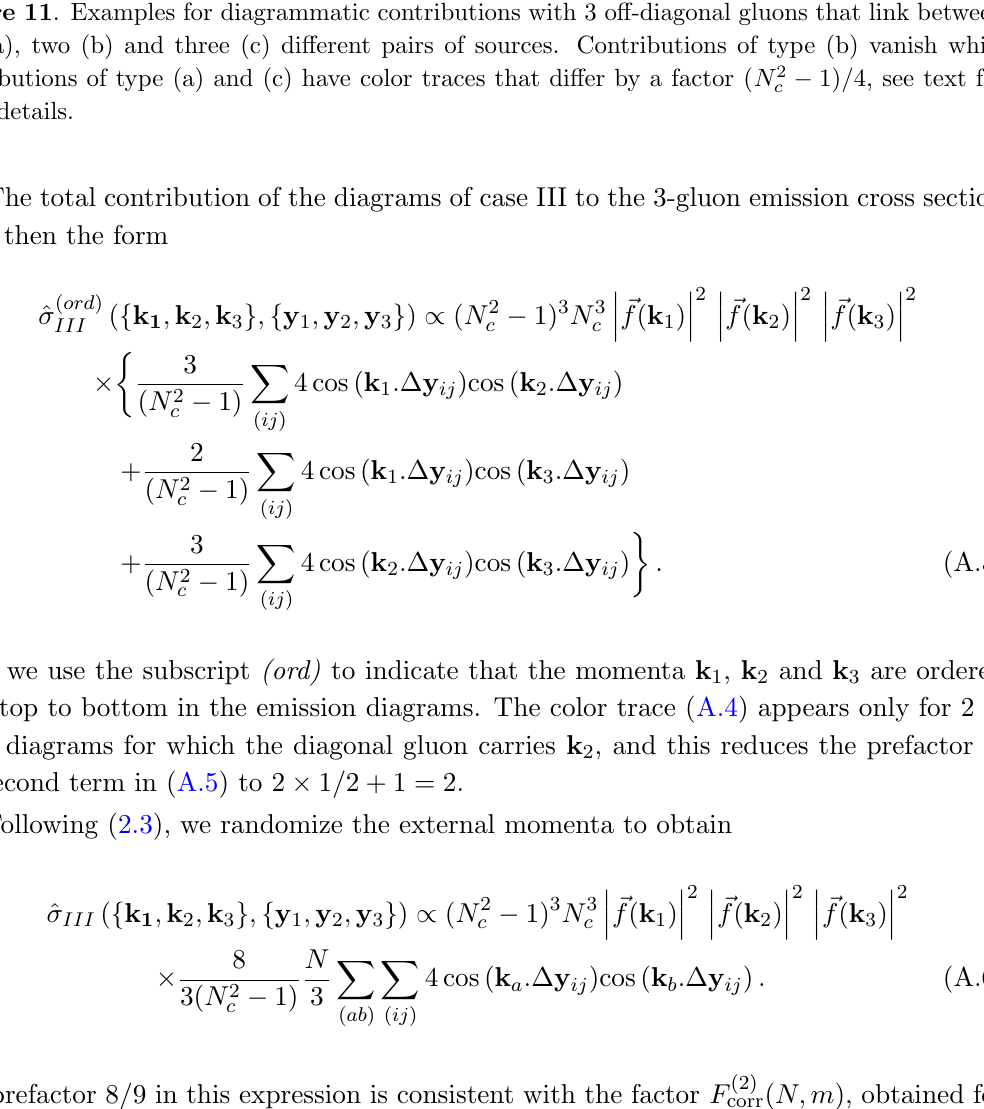
(cid:0) 1) = 4, see text for c